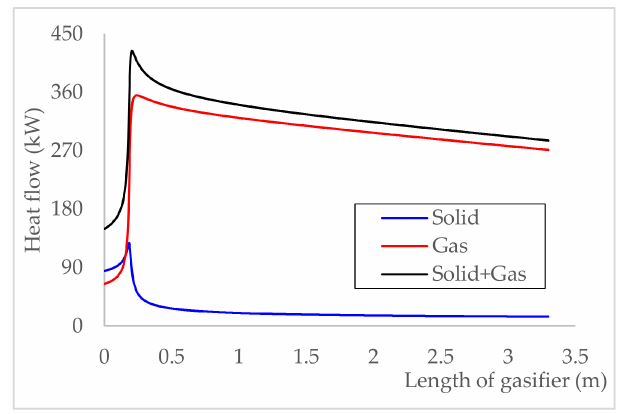
Figure 7. Heat flow of solid and